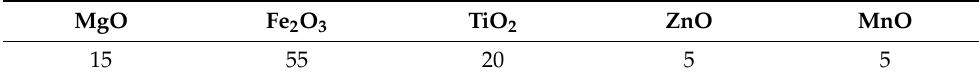
Table 1. The chemical composition of the ferrite ceramic (wt.%). MgO Fe 2 O 3 TiO 2 ZnO